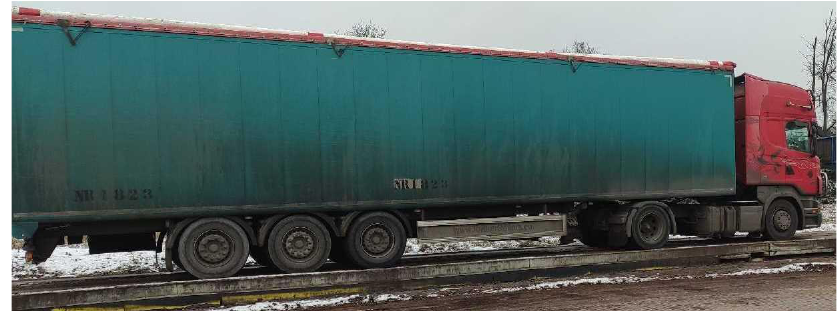
Figure 2. Weighing the truck to determine the GVW and tare.